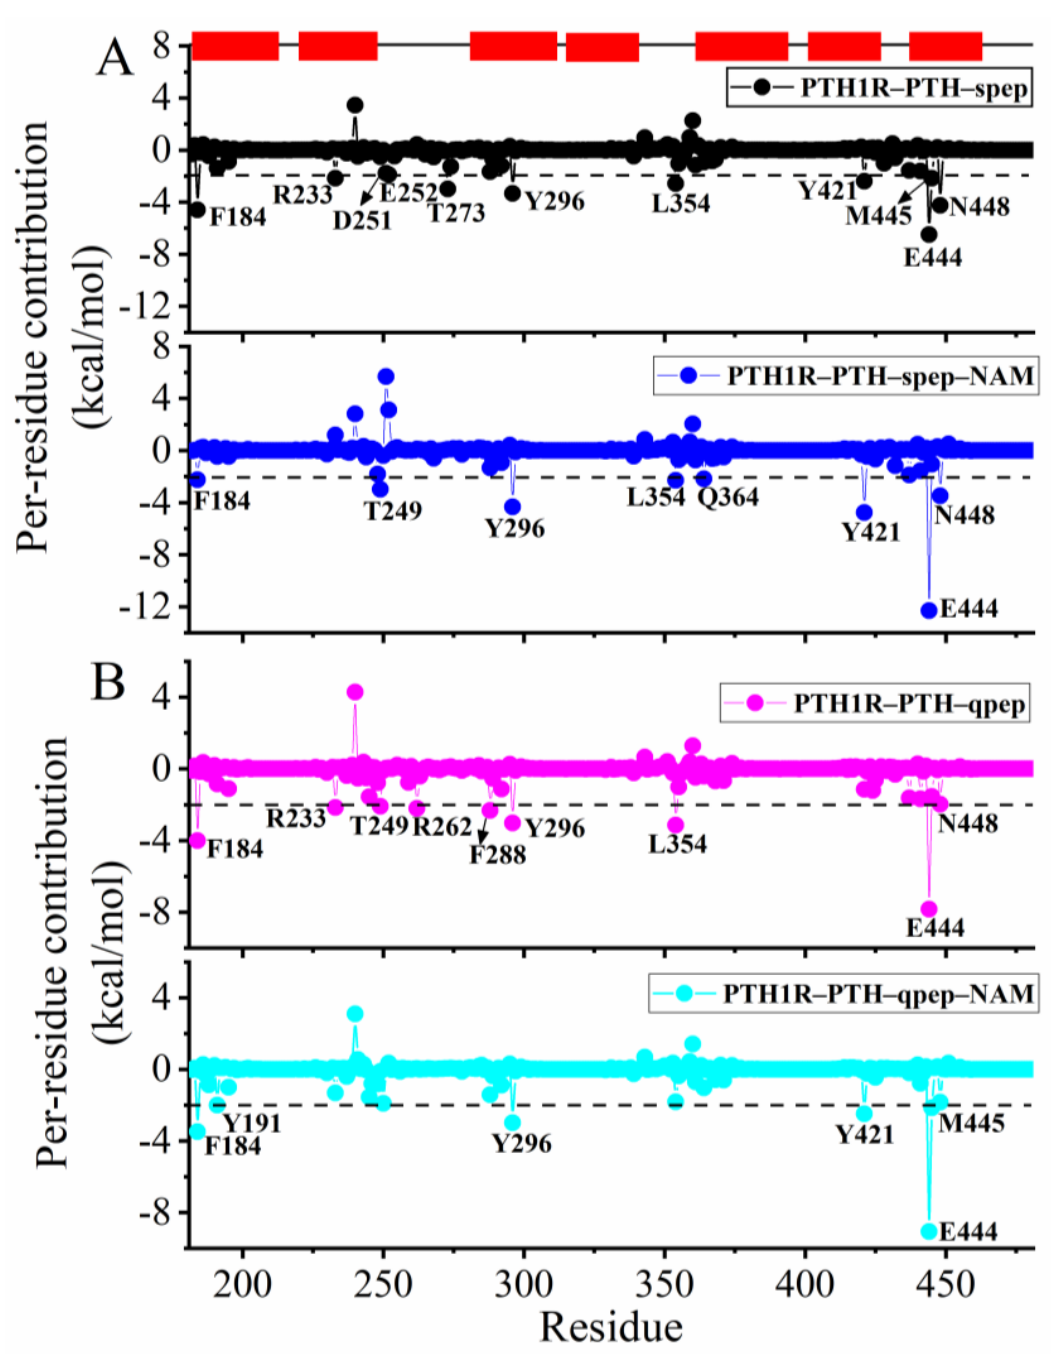
Figure 4. Residue contribution to the binding of PTH: ( A ) PTH1R–PTH–spep and PTH1R–PTH–spep–NAM systems; ( B ) PTH1R–PTH–qpep and PTH1R–PTH–qpep–NAM systems.